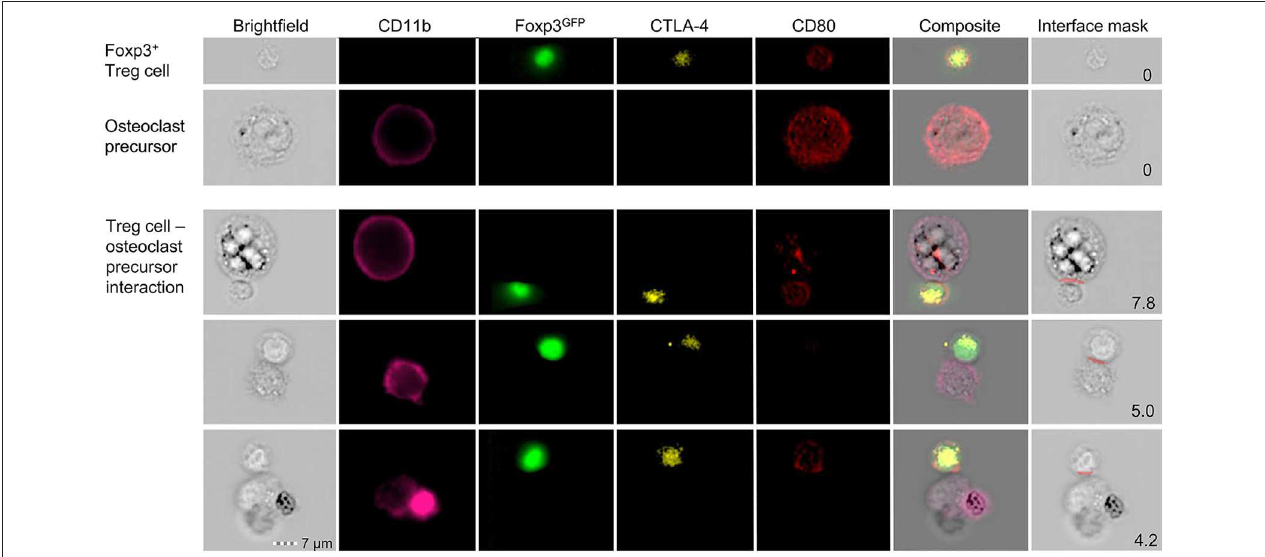
FIGURE 4 | Detailed characterization of in vitro Foxp3 + Treg cell-osteoclast precursor interaction. Representative single cell (upper panels) and cluster (lower panels) analysis by imaging flow cytometry. Stimulated FACS-purified CD4 + CD25 + Foxp3 GFP + Treg cells and freshly isolated irradiated T-cell-depleted splenocytes were added to the BM culture and cultured under osteoclastogenic conditions. After 48h, Foxp3 + Treg cells and CD11b + osteoclast precursors were analyzed for intracellular expression of CD80 and CTLA-4 by imaging flow cytometry. Cell clusters depict physical interaction of CTLA-4 + Foxp3 GFP + Treg cells and CD11b + osteoclast precursors. Co-localization of CD80 in Treg cells indicates trans-endocytosis from CD11b + osteoclast precursors. Numbers indicate the interface area and illustrate the overlapping fluorescence of Foxp3 and